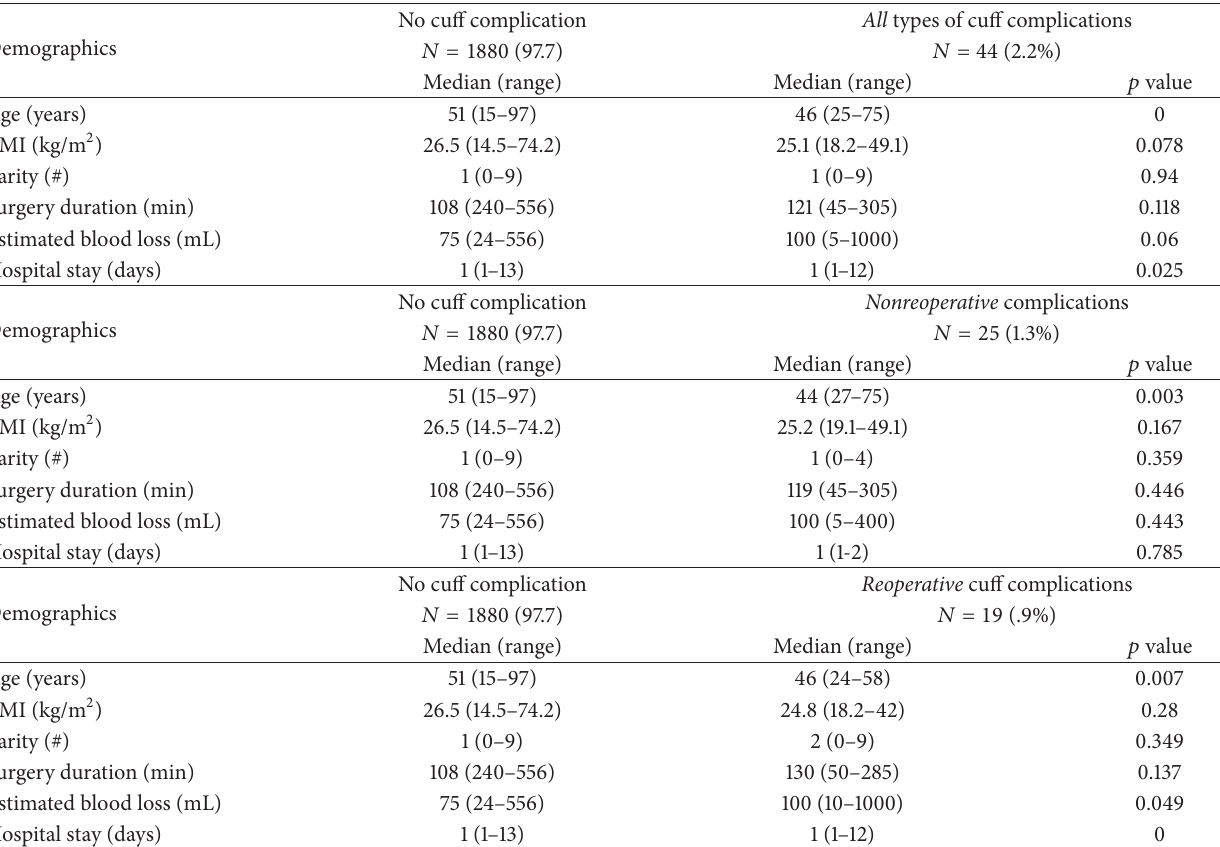
Table 2: Comparing demographic factors of those without a cuff complication with those having any or nonreoperative or reoperative complications.